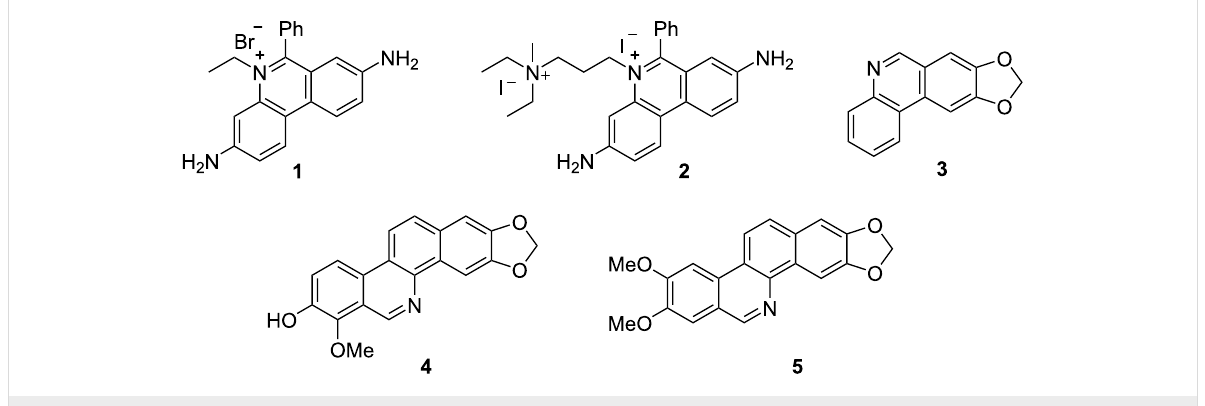
Figure 1: Biologically active phenanthridines.